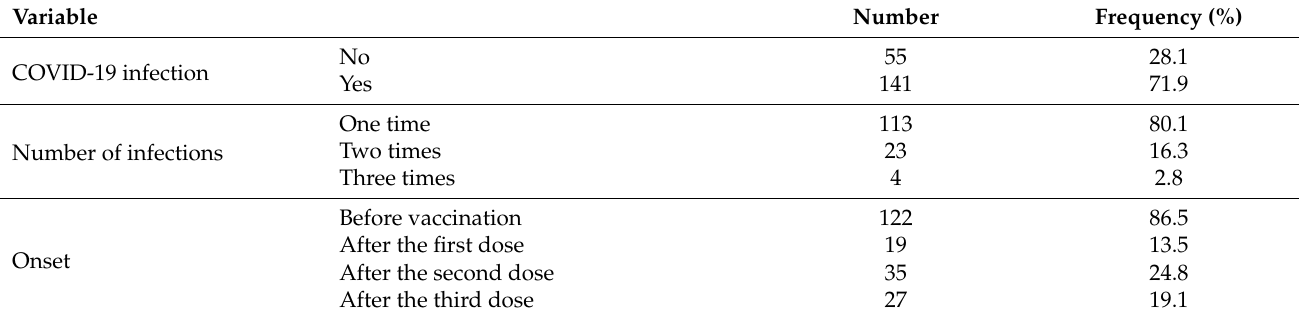
Table 2. COVID-19 infection history and booster uptake of the studied